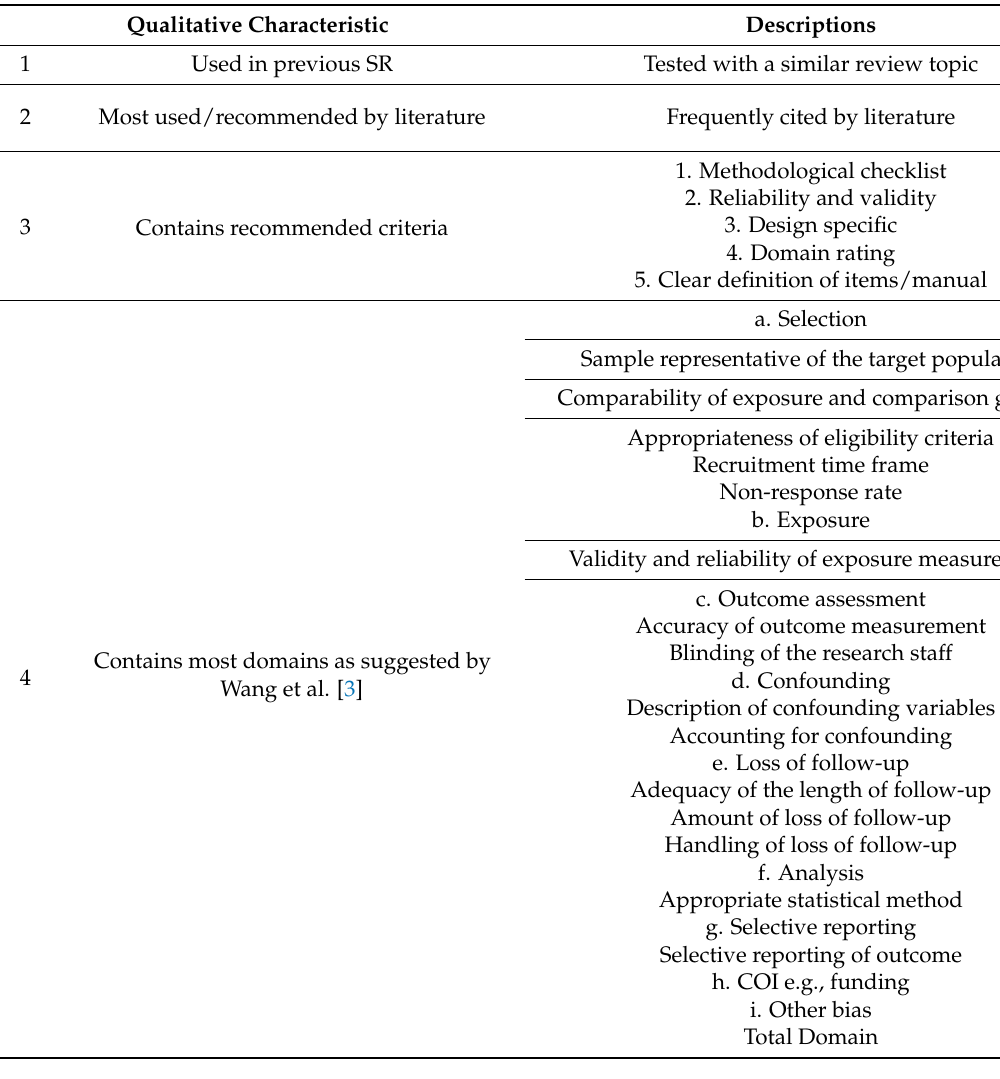
Table 6. Pros, cons, and consensus on the best instrument for cross-sectional